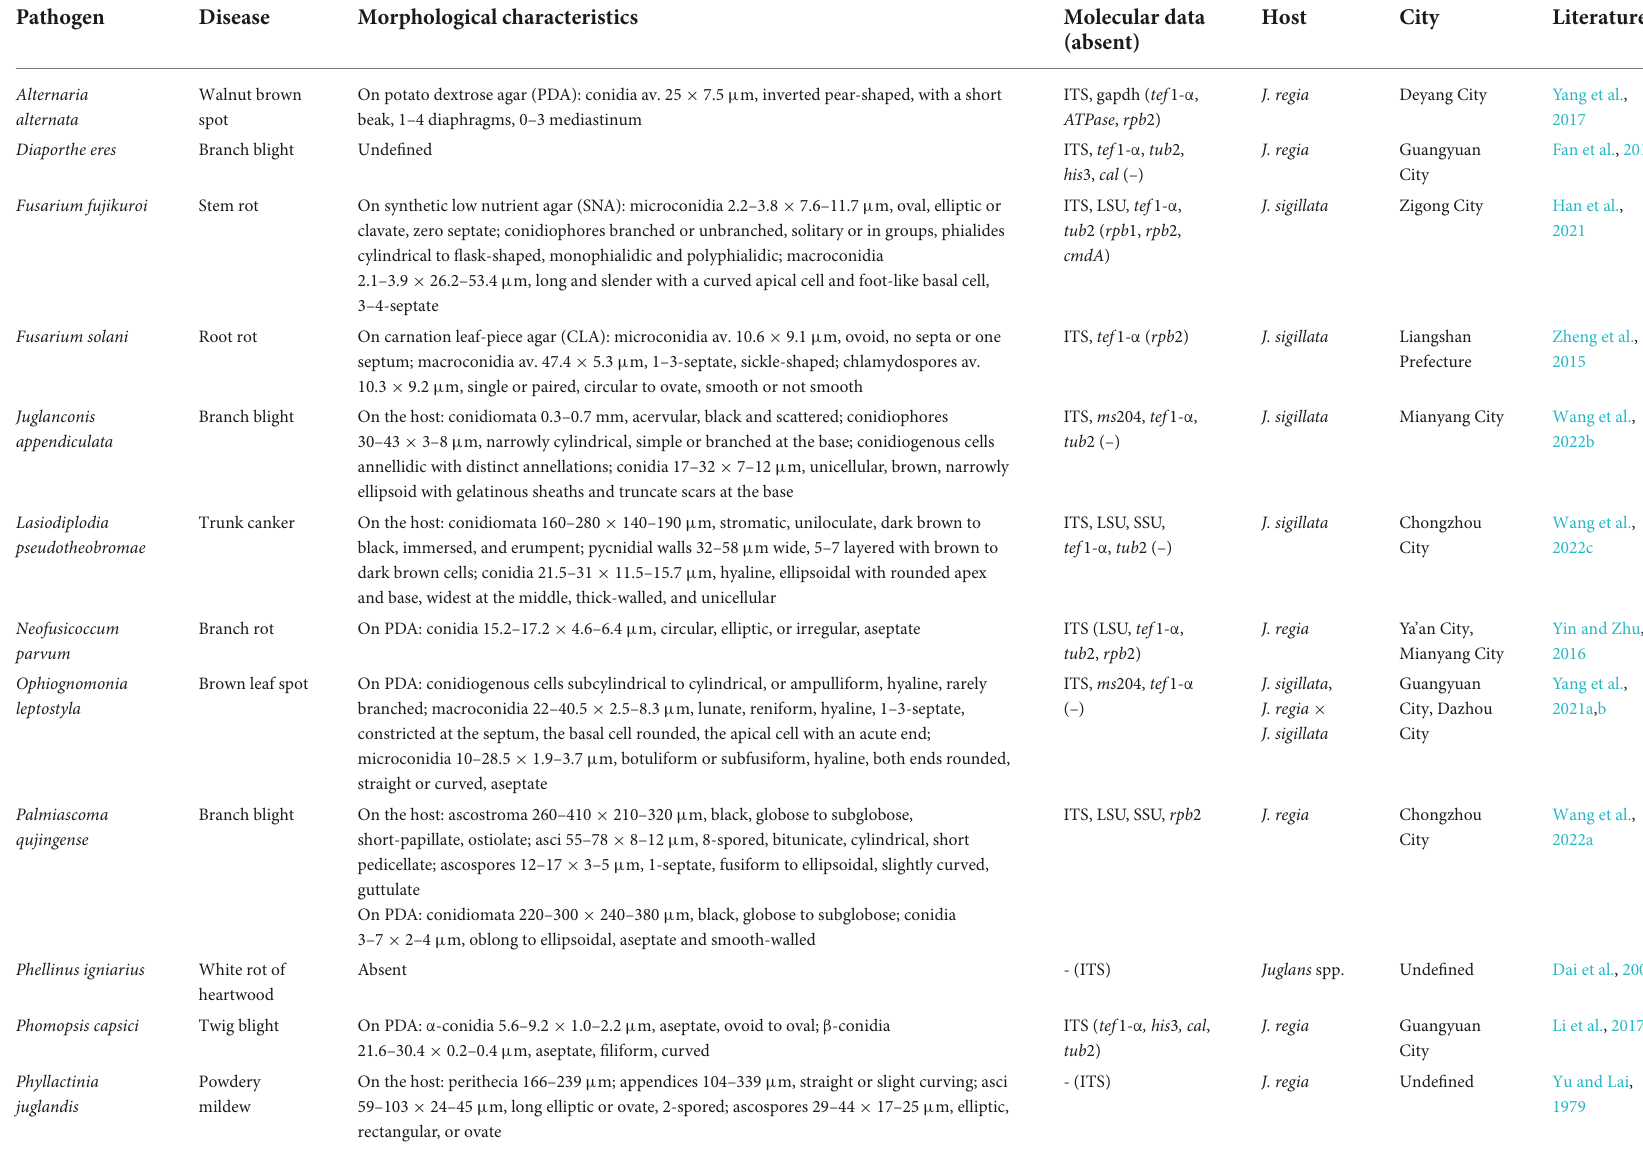
TABLE 1 Pathogenic fungi associated with walnut trees ( Juglans , Juglandaceae) with certain evidence in Sichuan